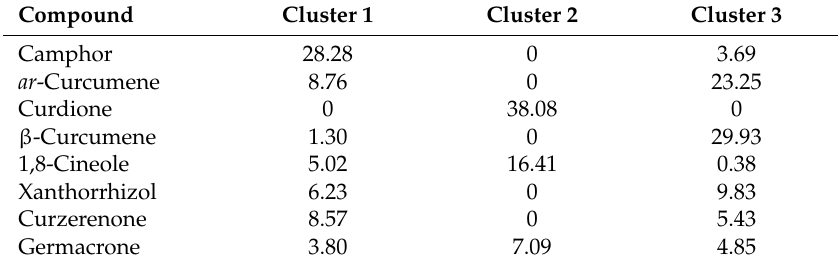
(Figure 3): (1) a cluster dominated by curzerenone/ epi -curzerenone followed by camphor, germacrone, 1,8-cineole, and α -copaene; and (2) a cluster represented by a single sample with very large concentrations of 1,8-cineole. The cluster centroids of the main constituents of C. zedoaria rhizome oils are summarized in Table